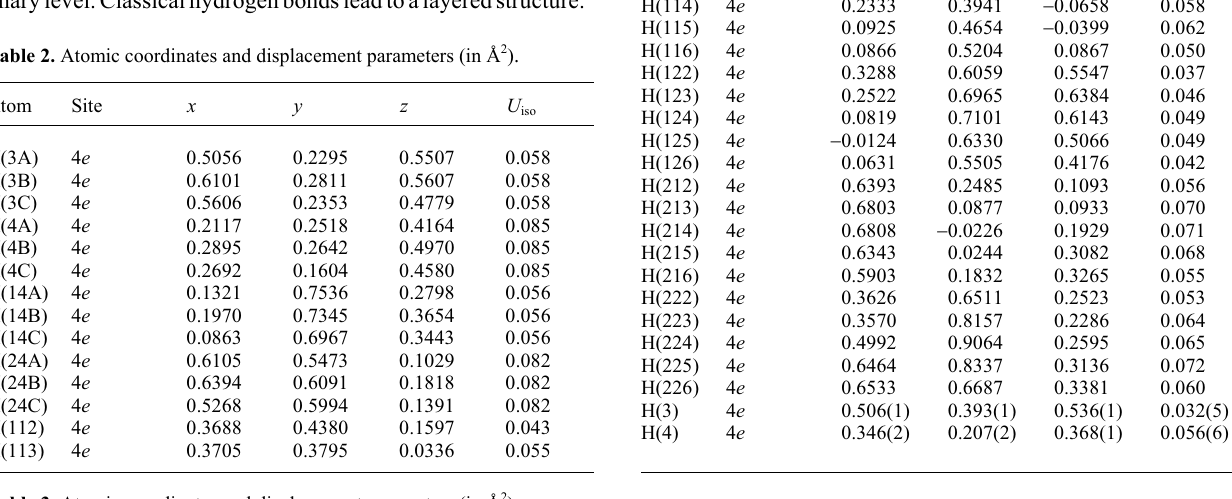
Table 3. Atomic coordinates and displacement parameters (in Å 2 )